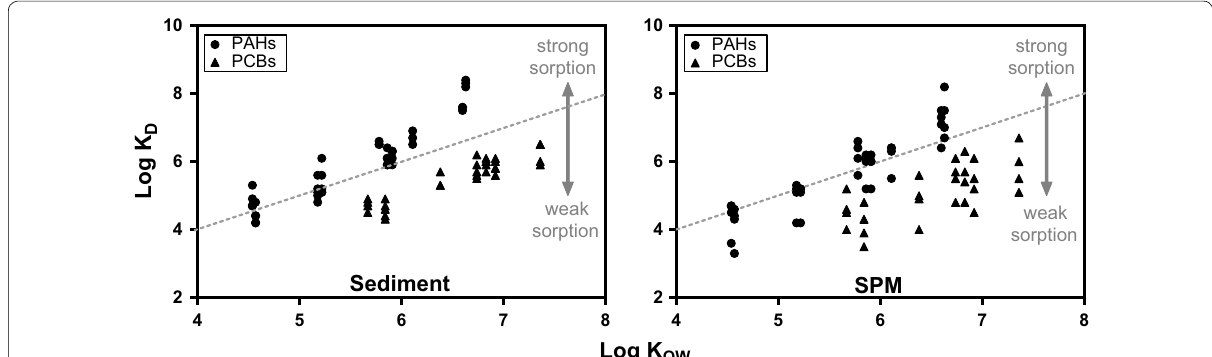
Fig. 4 Site-specific distribution ratios ( K D ) values plotted over Log K OW of PAHs and PCBs for sediment and SPM samples. K D values were calculated for five sediment stations with C free n